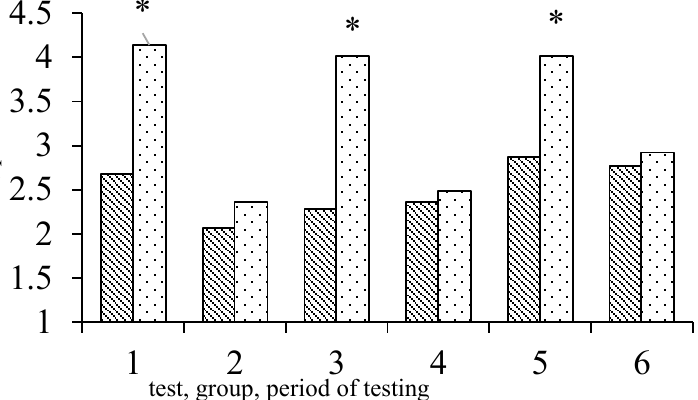
Fig.3 Results of experts’ assessment of motor skills of experimental (n=21) and control (n=22) groups’ pupils before and after experiment